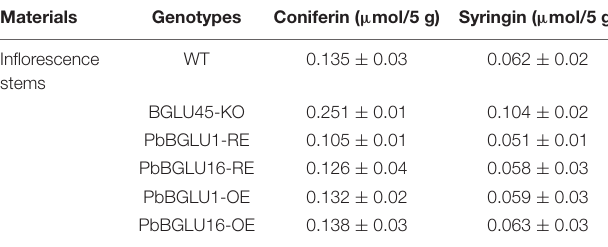
TABLE 2 | HPLC analysis of soluble monolignol glucosides metabolites in Arabidopsis